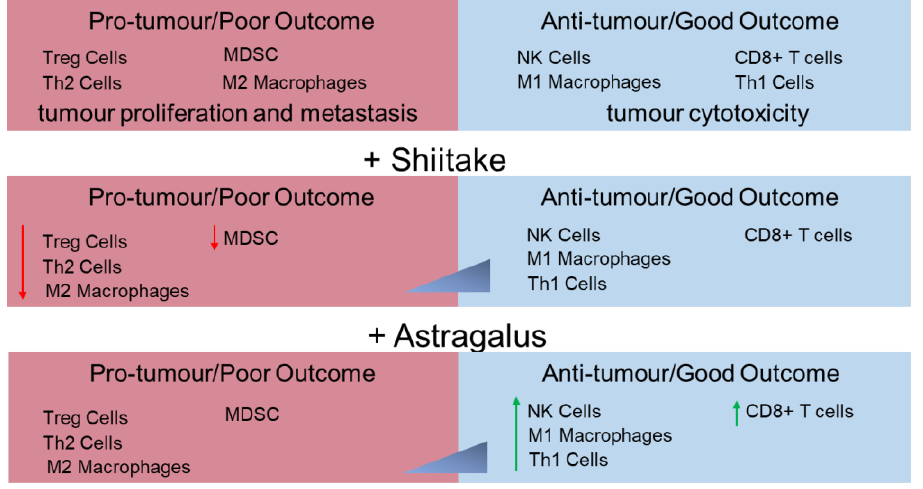
Figure 2. Immunomodulatory functions of Astragalus and Shiitake in tumour immune microenviron- ment. (MDSC–Myeloid-derived suppressor